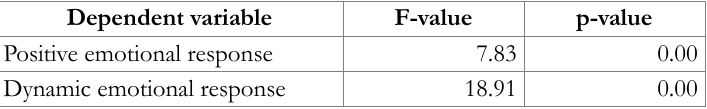
Table 4. One-way ANOVA tests for Teaching Method vs Emotional Responses categorized in terms of the applied taxonomy of